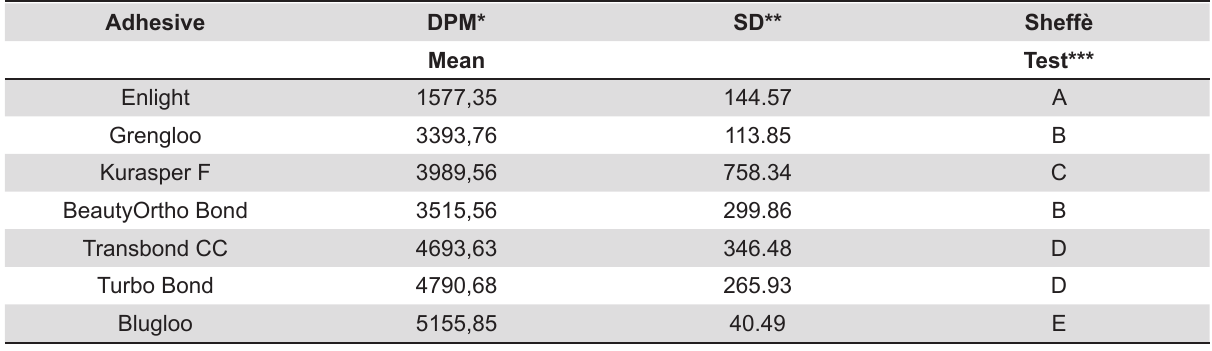
Table 1- Quantitative test to S. mutans by radiolabeled ( 3 H)